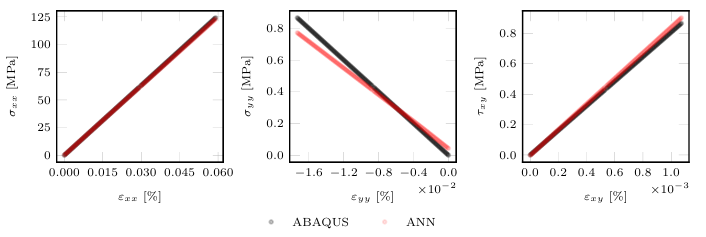
( a ) Elastic model—element #1: m = 12, b = 100.